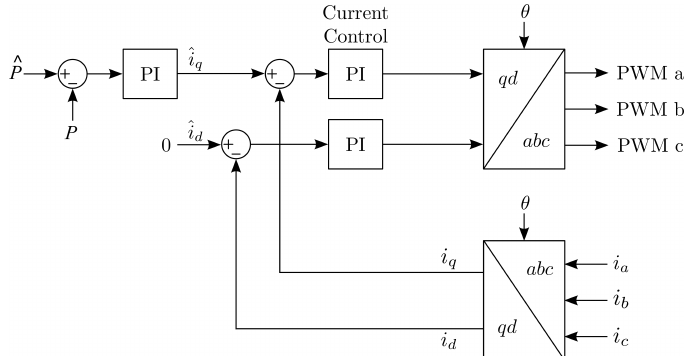
Figure 4. Field-oriented